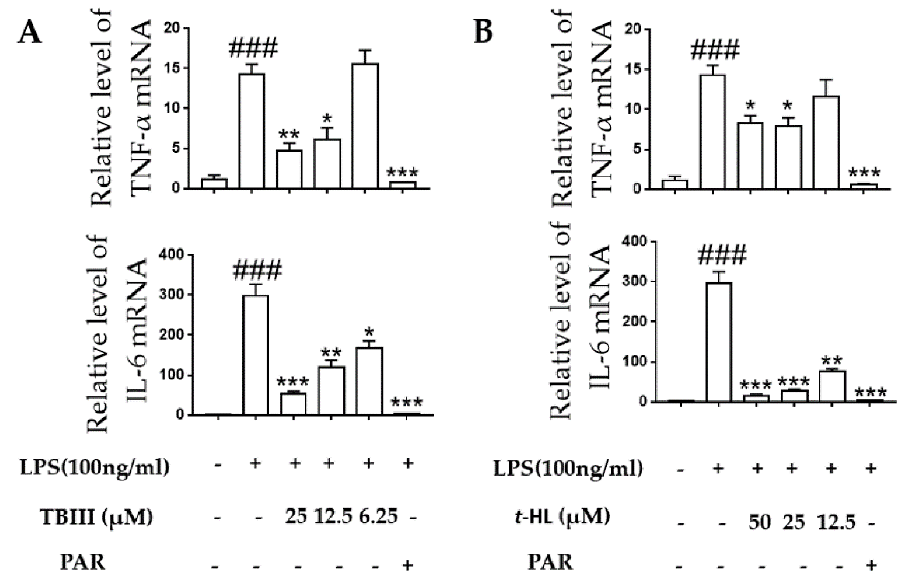
Figure 4. Effects of TBIII ( A ) and t -HL ( B ) on LPS-induced mRNA expression of pro-inflammatory cytokines in N9 microglial cells. Cells were treated with different concentrations of TBIII and t -HL for 1 h and then stimulated with LPS (100 ng/mL) for 4 h. TNF-α and IL-6 mRNA levels were determined by real-time PCR analysis. PAR (10 μM ) was used as a positive control. The data were obtained from three independent experiments and expressed as the means ± S.E.M. * p < 0.05, ** p < 0.01, *** p < 0.001 versus the LPS-treated group; ### p < 0.001 versus the control group.